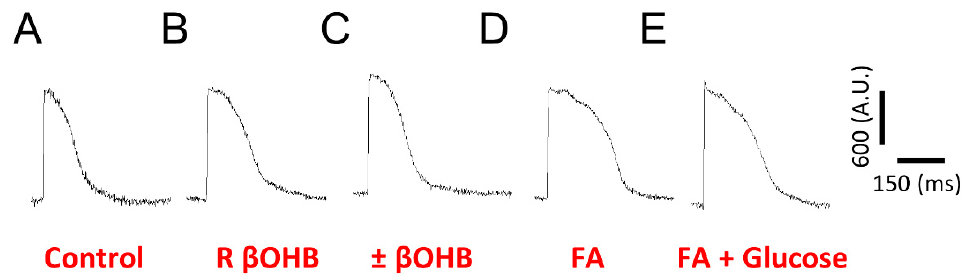
Figure 2. Ensembled averaged representative FluoVolt optical action potentials (AP) recorded from iPS-CMs cultured in either ( A ) control media, ( B ) R β OHB, ( C ) ± β OHB, ( D ) fatty acid media, or ( E ) fatty acid + glucose media.